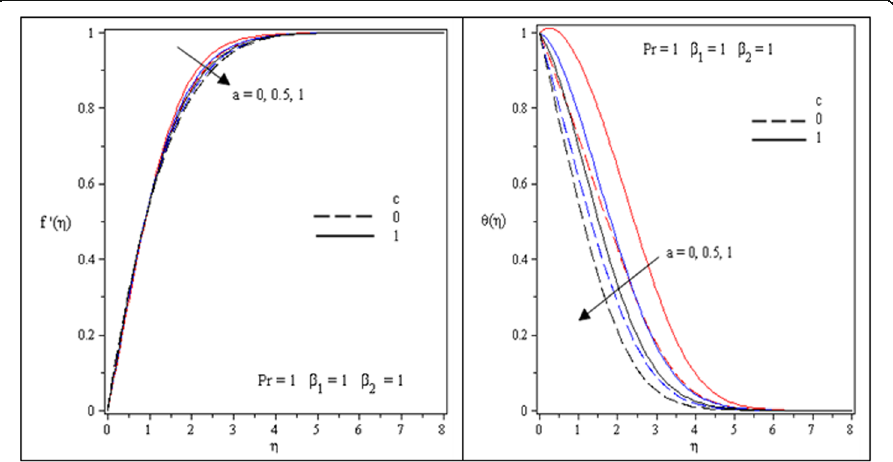
Fig. 5 Velocity and temperature profiles for the temperature power exponent parameter with and without